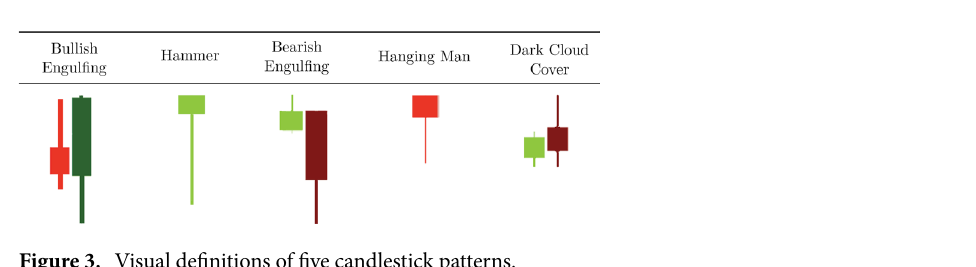
Figure 3. Visual definitions of five candlestick